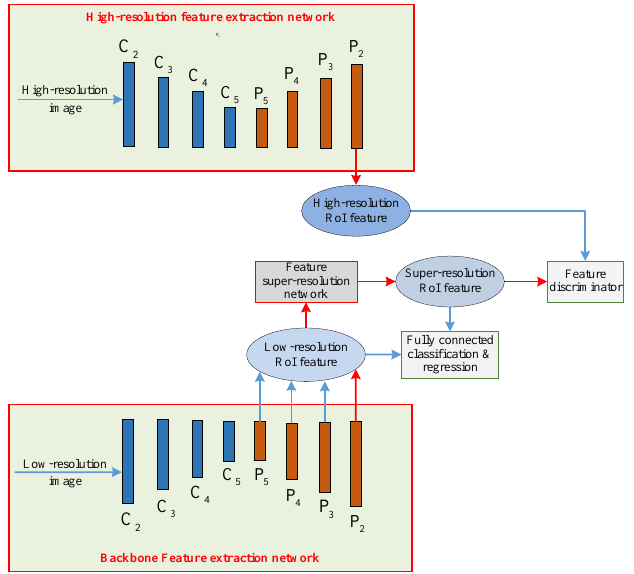
Figure 8. The training pipeline of the proposed